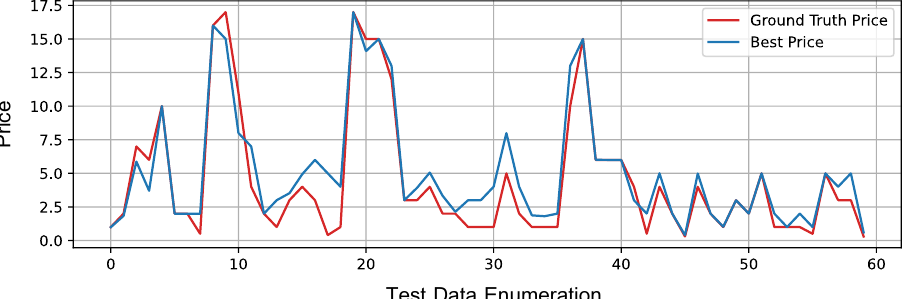
Figure 4. Comparison between the ground truth and the best price prediction obtained through the proposed model, after feature selection, based on Probability, Plausibility, Credibility, and Possibil- ity